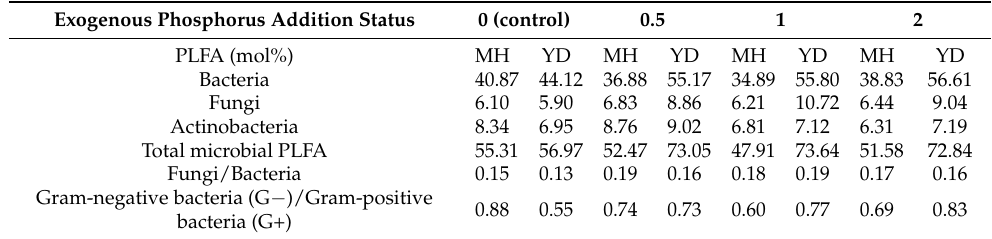
Table 4. Relative contents of soil microbial PLFAs at the jointing stage of rice (MH indicates Hui 86 rice; YD indicates